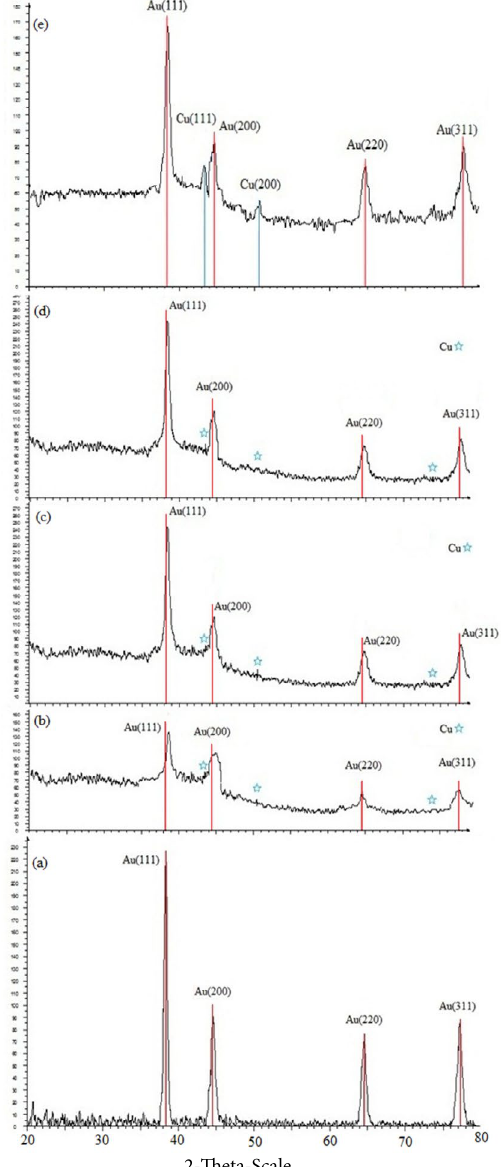
Fig. 2. X-ray diffraction patterns of the (a) pure Au, (b) 90% Au, (c) 75% Au, (d) 50% Au, (e) 25% Au.